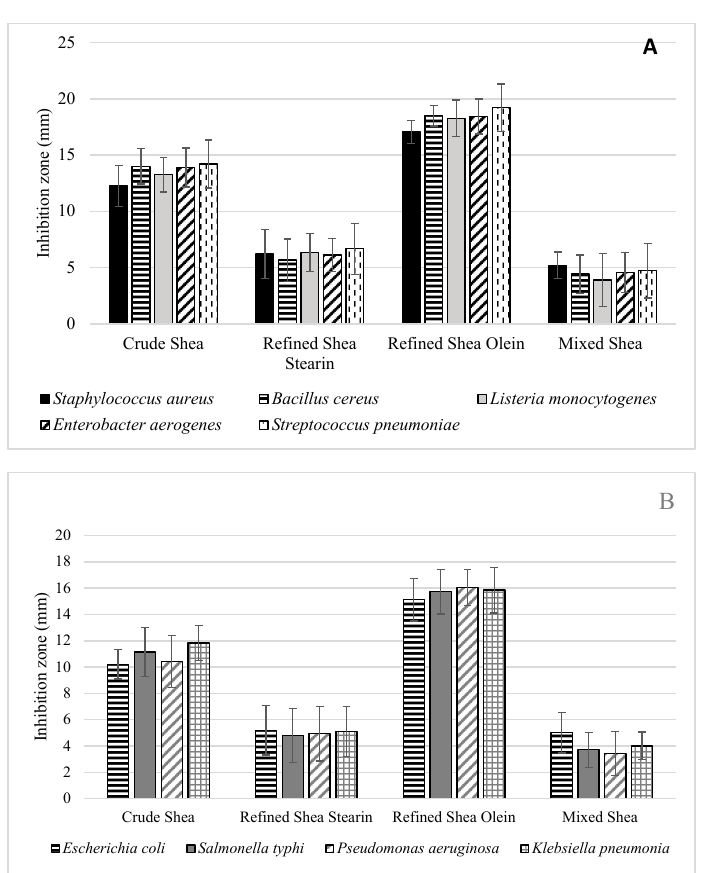
Figure 2. Antibacterial activity of crude shea butter, refined shea stearin, refined shea olein and a mixture (olein:stearin 1:1 w / w ) determined against Gram-positive ( A ) and Gram-negative ( B ) path- ogens.